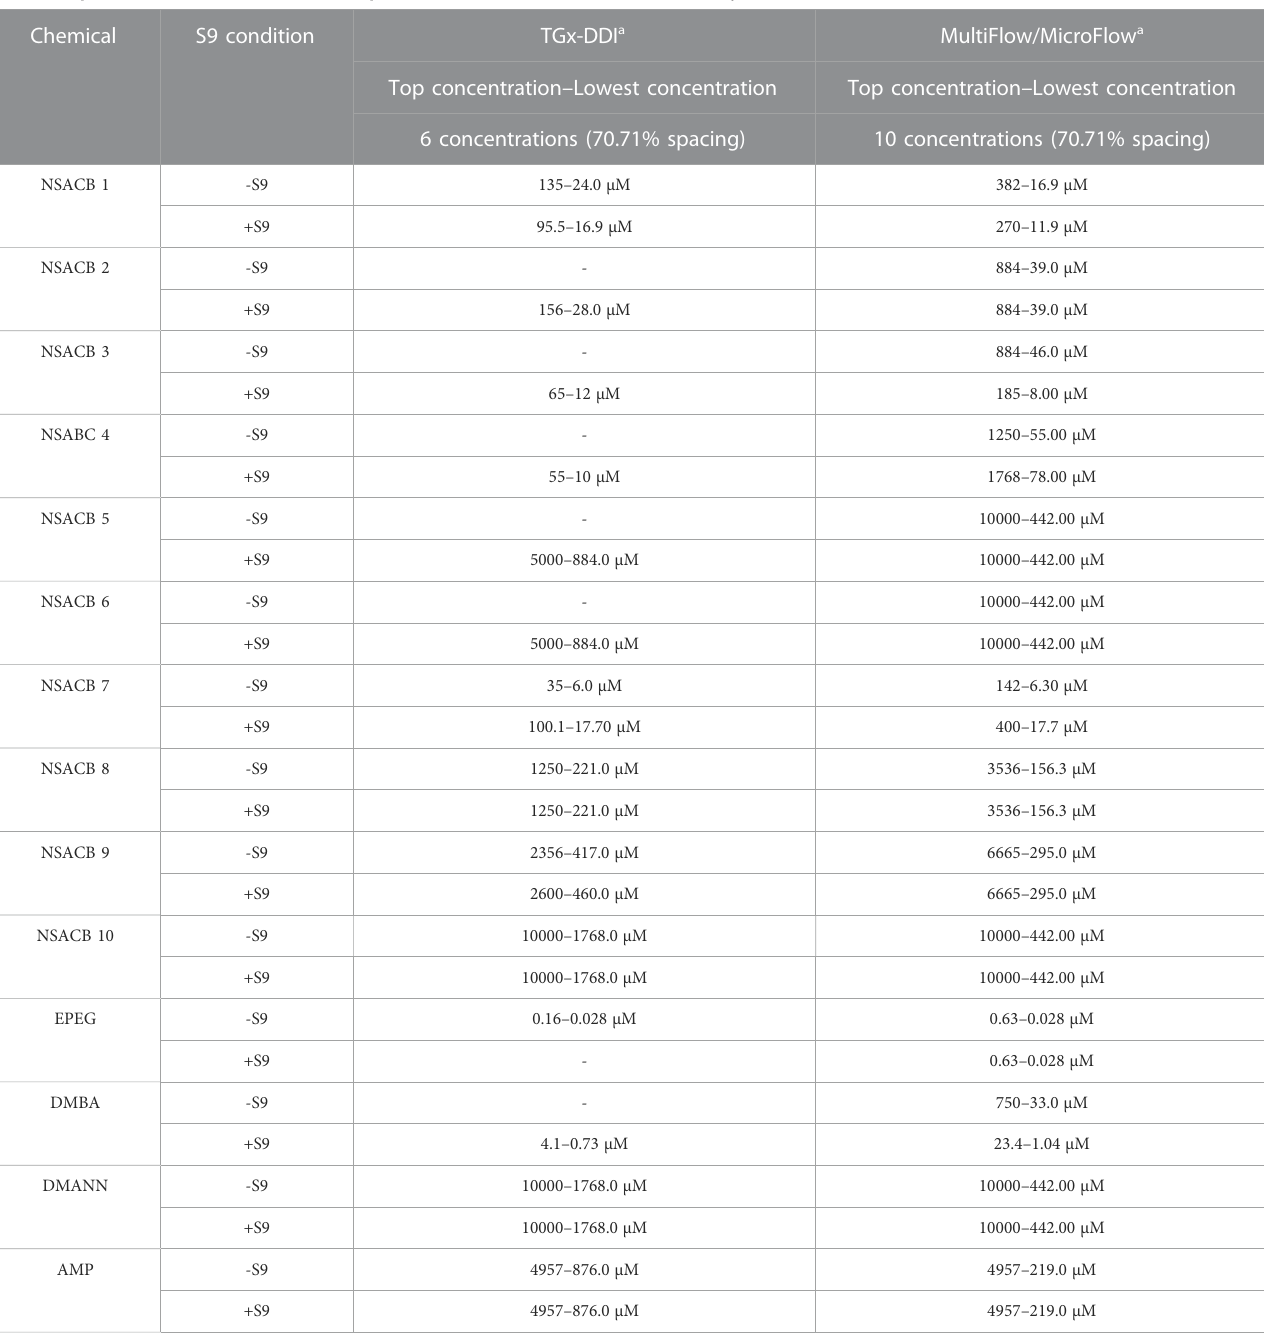
TABLE 2 Experimental information for the data-poor chemicals and controls used in this study. Chemical S9